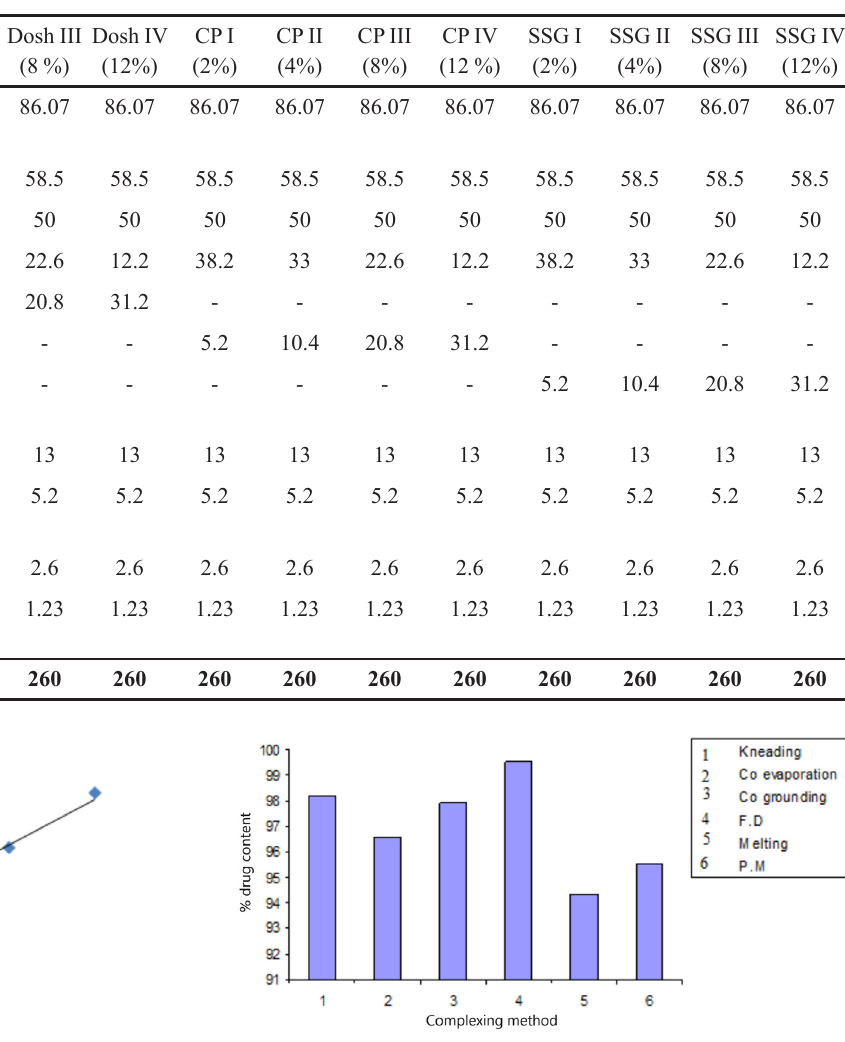
FIGURE 2 - Drug content in drug-β-cyclodextrin (1:1)